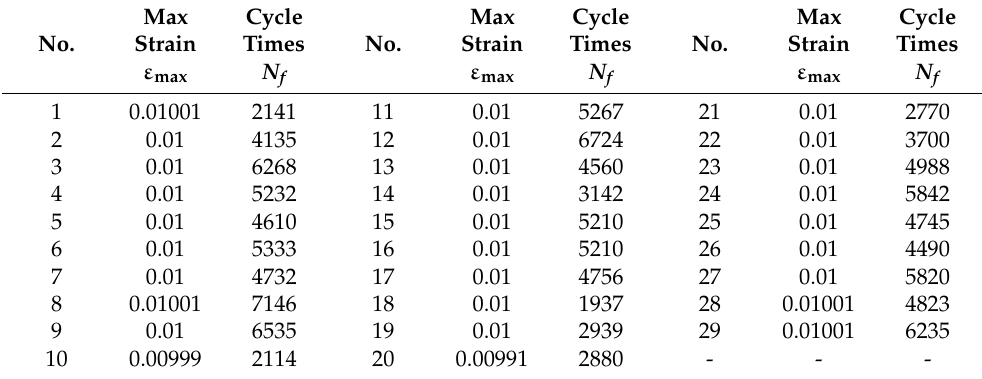
Table A1. Fatigue test data of T = 530 ◦ C, R = 0.05, strain range 0.95%.